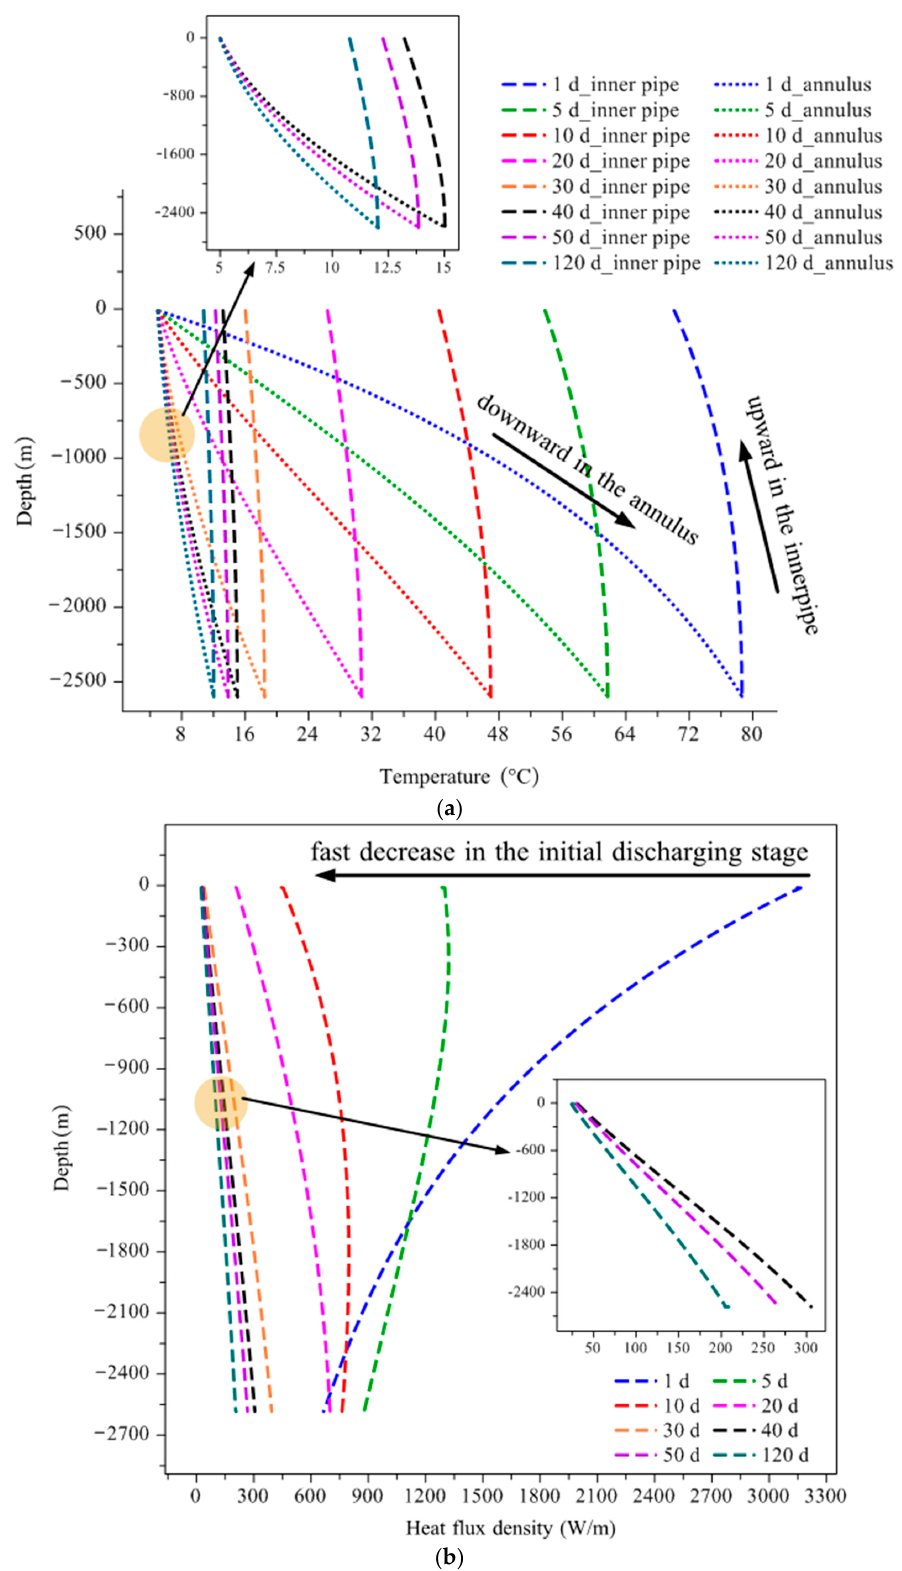
Figure 17. Simulation results for thermal performance of the deep BTES system during 120 days of discharging after high temperature heat storage: ( a ) Circulating flow temperature profile along depth of borehole; ( b ) Heat flux density distribution along depth of